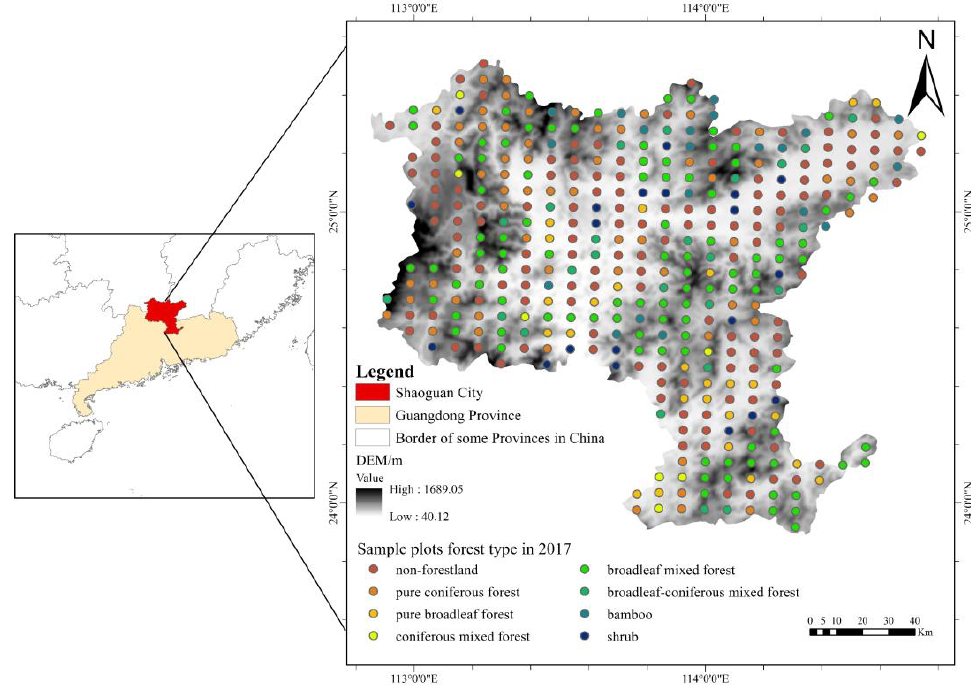
Figure 1. Location of Shaoguan City, Guangdong Province, together with the DEM.